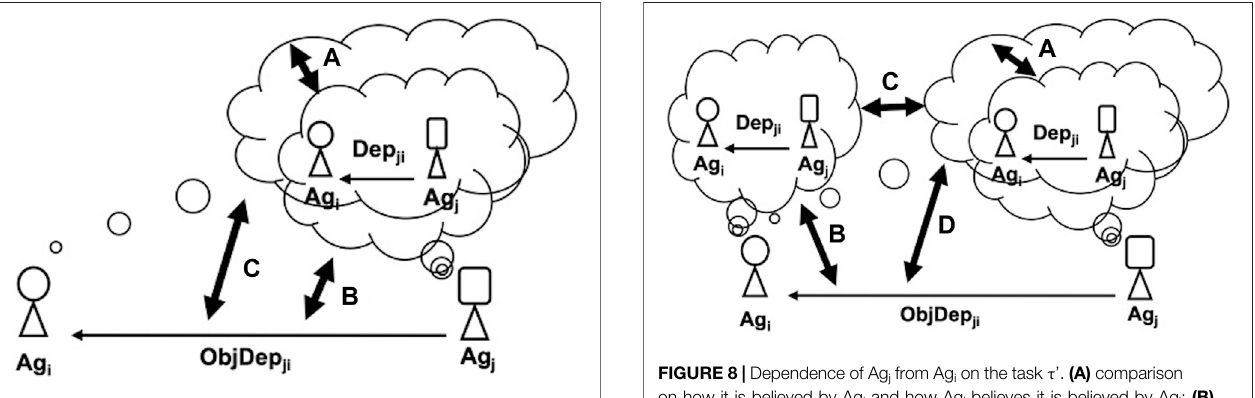
( Bel ) (cid:1) Ag i ( ObjDep i,j, τ j ( ObjDep i,j, τ ) ≠ i ( Bel ) ≠ Ag i ( ObjDep i,j, τ j